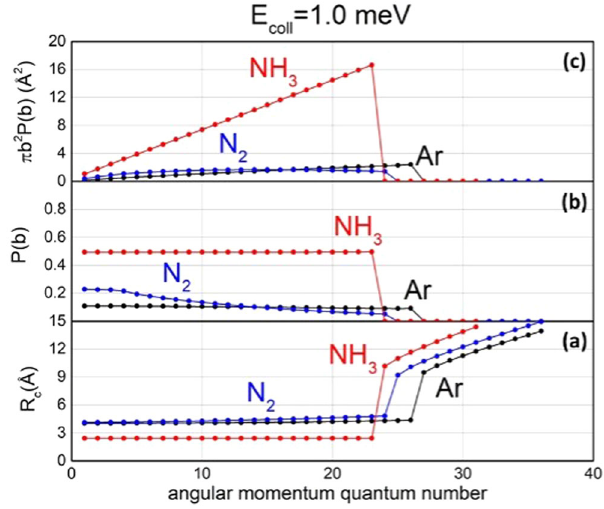
Fig. 5 The role of the angular momentum quantum number on the selectivity of Ne * + Ar, N 2 , NH 3 reactivity. Comparison between R c ( a ), the reaction probability P(b) ( b ), and the ionization cross